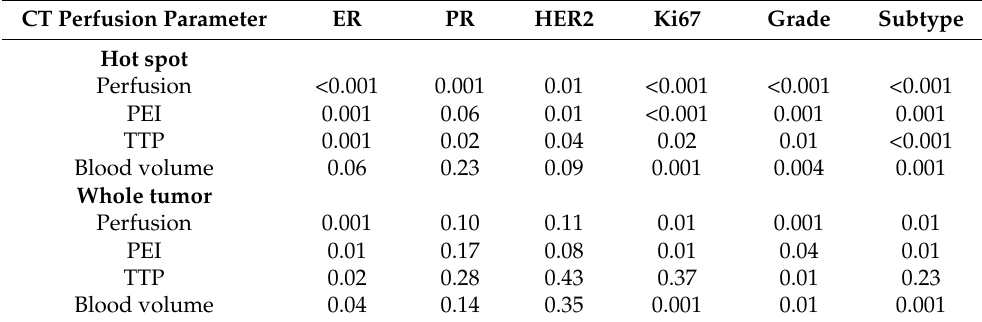
Table 2. p values for association tests between CT perfusion parameters and histological factors in the training set.